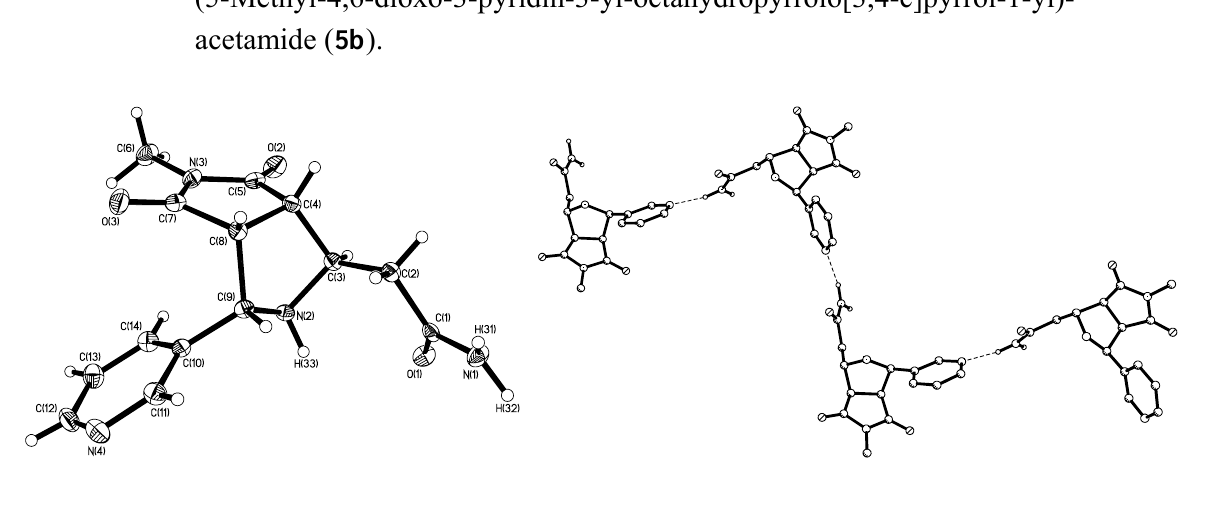
Figure 2. X-ray structure and molecules packing in crystal of (1S*, 3R*, 3aS*, 6aR*)-2- (5-Methyl-4,6-dioxo-3-pyridin-3-yl-octahydropyrrolo[3,4-c]pyrrol-1-yl)- acetamide ( 5b ).